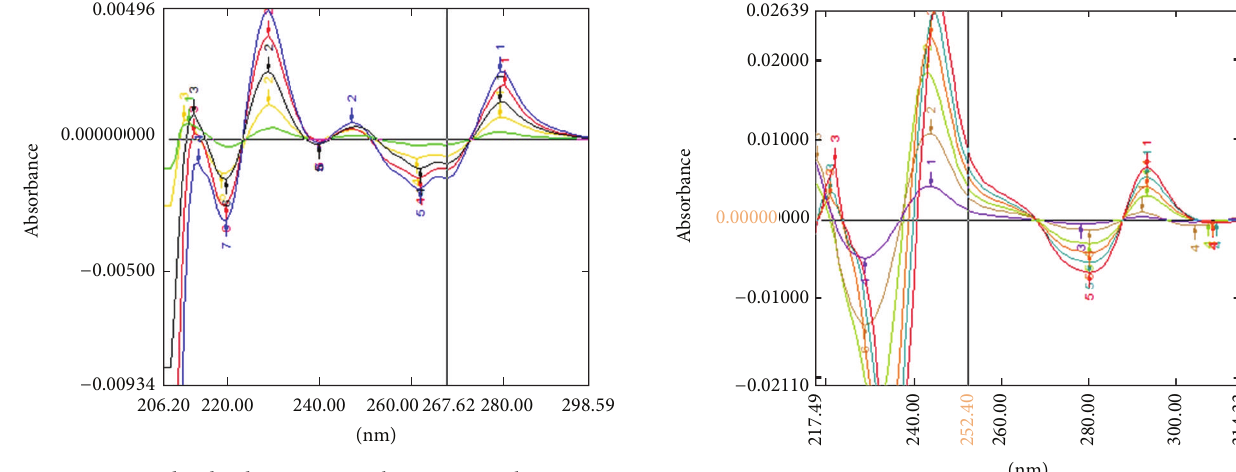
Figure 3: Second order derivative UV absorption overlain spectra of PRA (5–45 𝜇 g/mL). Figure 4: Second order derivative UV absorption overlain spectra of ASP (25–150 𝜇